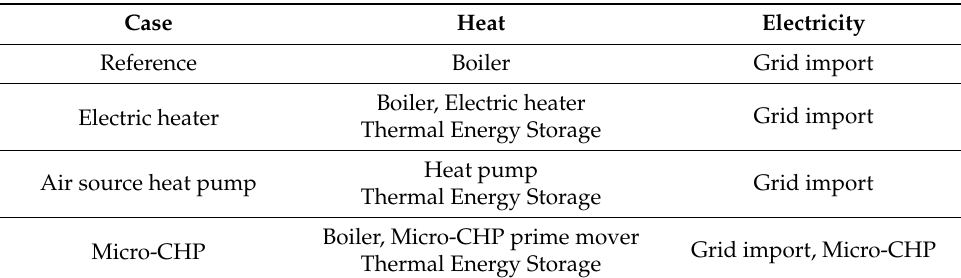
Table 3. Heating technology options.